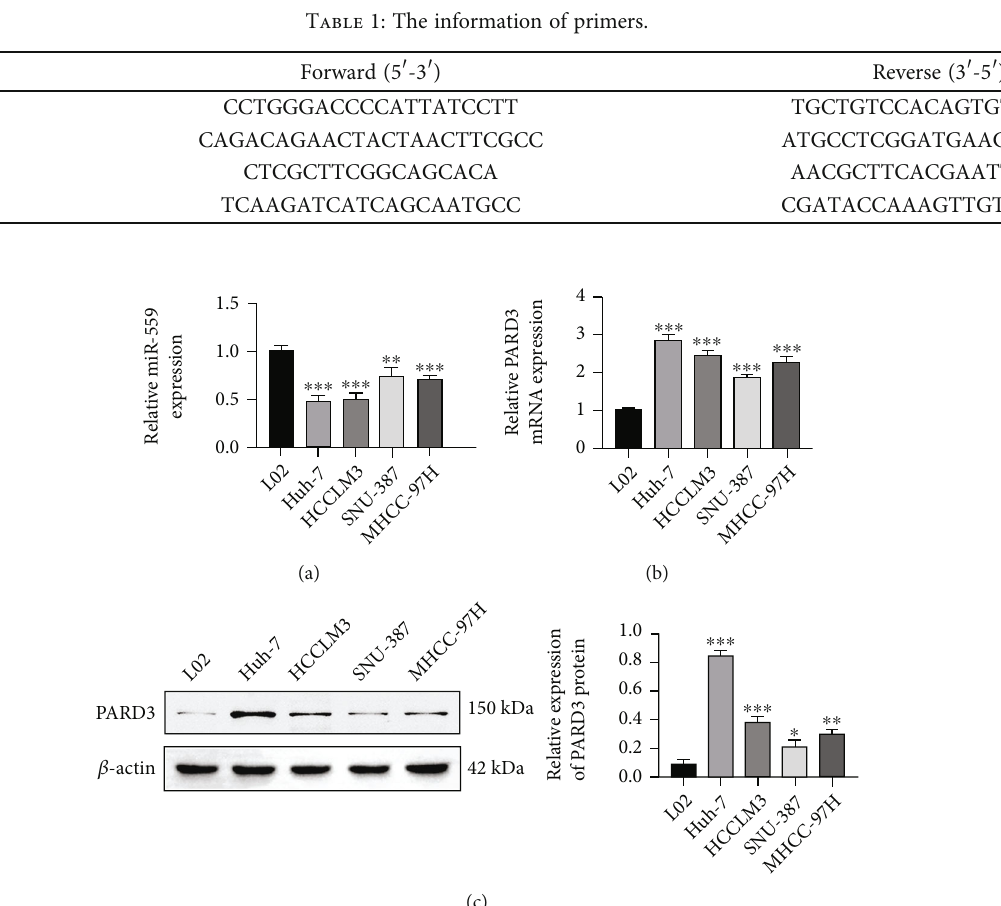
Figure 1: miR-559 was downregulated, and PARD3 was upregulated in HCC cells. (a) The expression level of miR-559 in HCC cells. (b) The mRNA expression of PARD3 in HCC cells. (c) The protein level of PARD3 in HCC cells. The values were obtained from three independent experiments and shown as mean ± SD . ∗ p < 0 : 05 , ∗∗ p < 0 : 01 , and ∗∗∗ p < 0 : 001 , compared with L02